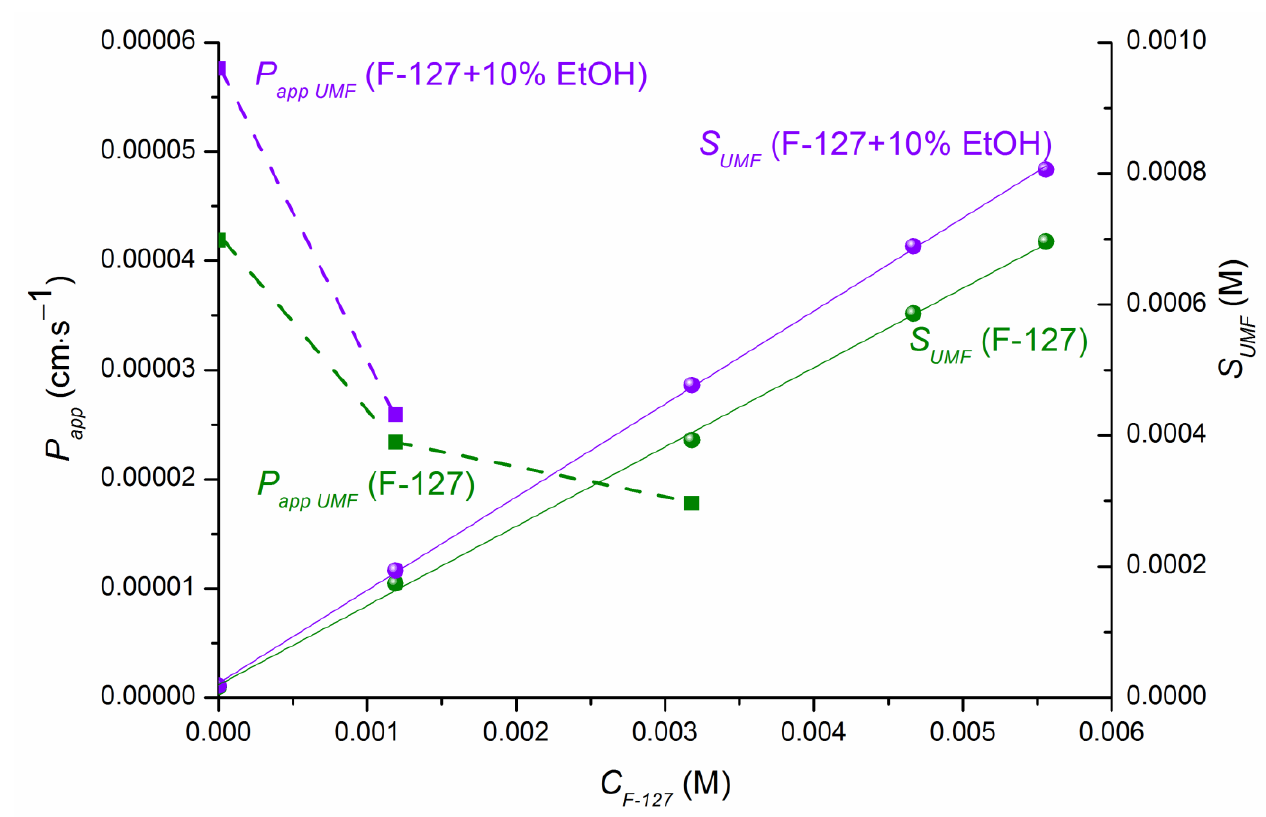
Figure 5. Solubility–permeability relationship exemplified by the effect of F-127 (green) and the combined effect of F-127 and 10% EtOH (violet).